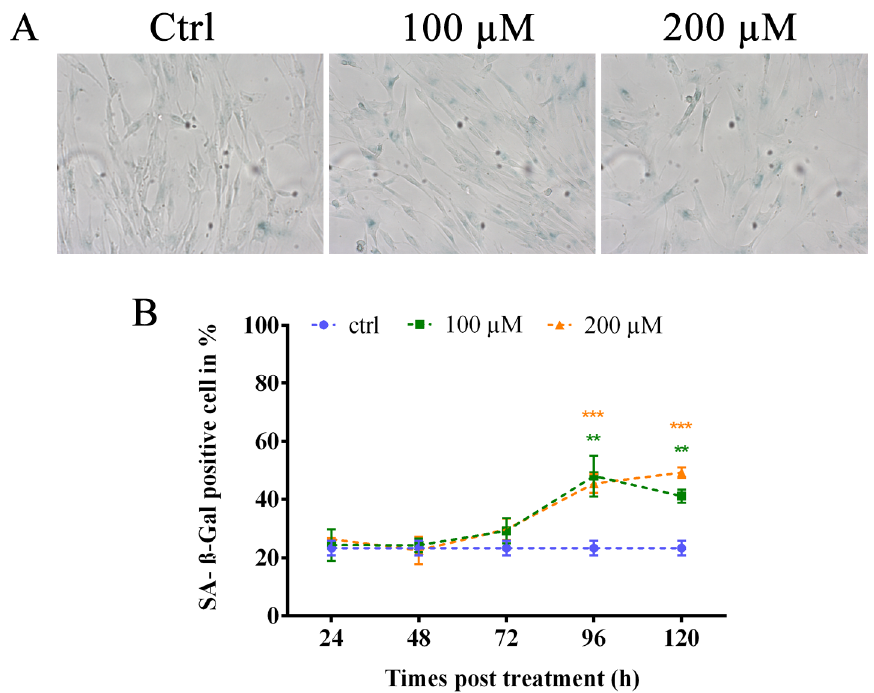
Figure 5. Analysis of SA- β -galactosidase-positive cells. ( A ) Representative images of positive SA- β -Gal-positive cells. ( B ) The graph represents data obtained from the analysis of the percentage of SA- β -galactosidase-positive cells. Control values are shown as the mean of the controls analyzed at different times. We observed a significant increase in the percentage of SA- β -Gal-positive cells at 96 h after treatment at both doses of hydrogen peroxide that persisted at 120 h after treatment. The error bars denote the standard error. ** p < 0.01; *** p < 0.001 by Student’s t-test.